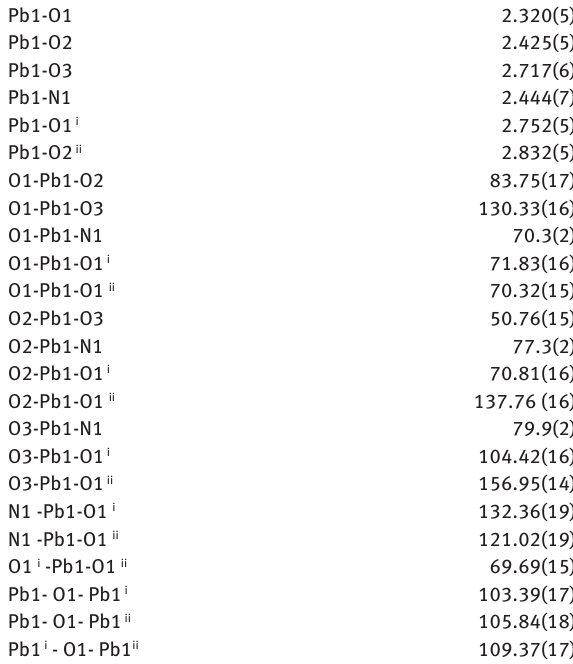
Table 1: Selected bond lengths (Å) and angles (deg) for the compound.